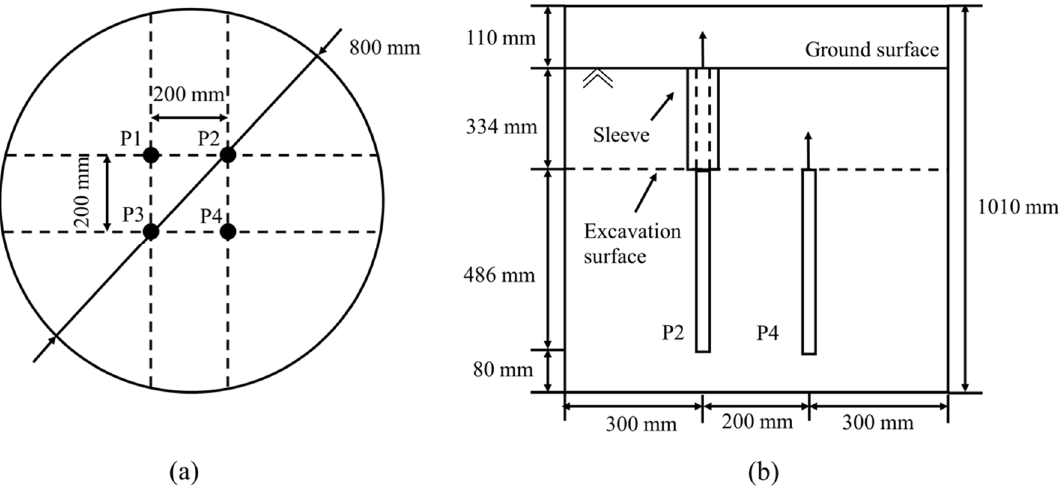
Figure 10. A sketch of the centrifuge tests: ( a ) plane view, ( b ) front view. The soil used in the model test is sandy silt with a dry density of 1.53 g/cm 3 . The soil mechanical and physical properties are summarized in Table 3. After saturation of the soil, the piles P1 and P2 were uplifted with a loading speed of 1.2 mm/min. Then, the soil was excavated up to a depth of 334 mm, and the piles P3 and P4 were uplifted with the same loading speed. Table 3. Mechanical properties of sandy silt and parameters of pile–soil interface.